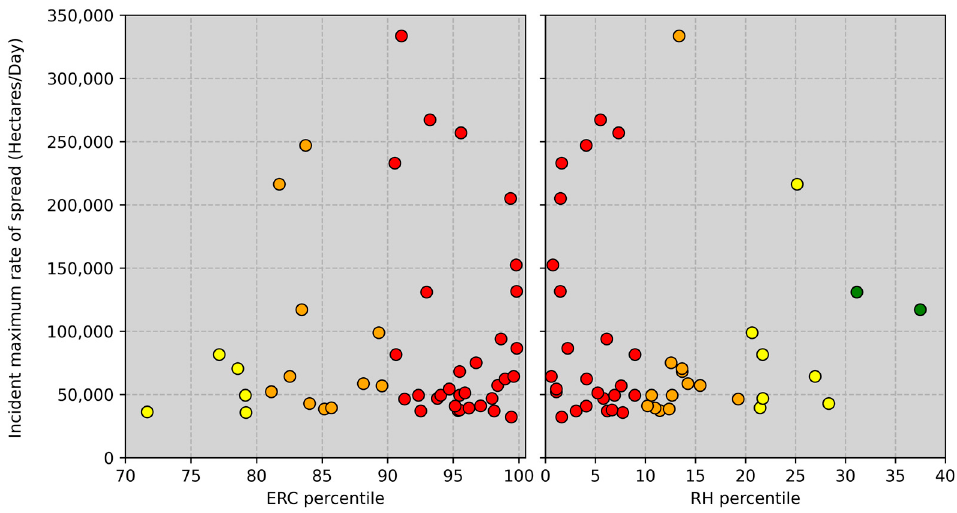
Figure 3. ERC and RH percentiles for large incidents exceeding the statewide breakpoint daily maximum ROS in ID, 1999–2014. Colors correspond to numerical scores in order, red being 5, orange 4, yellow 3, green 2, and blue 1 (refer to Table 2 for exact scoring